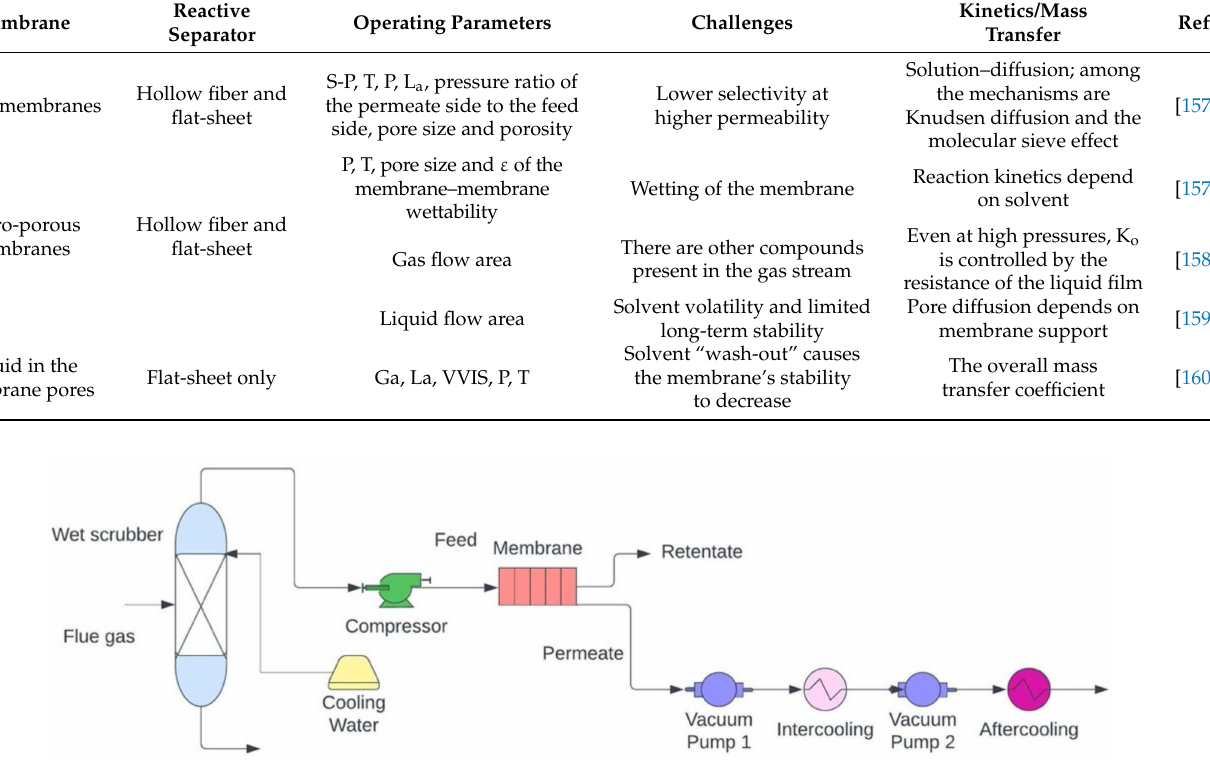
Figure 6. Schematic of membrane carbon capture process (adapted from Wang